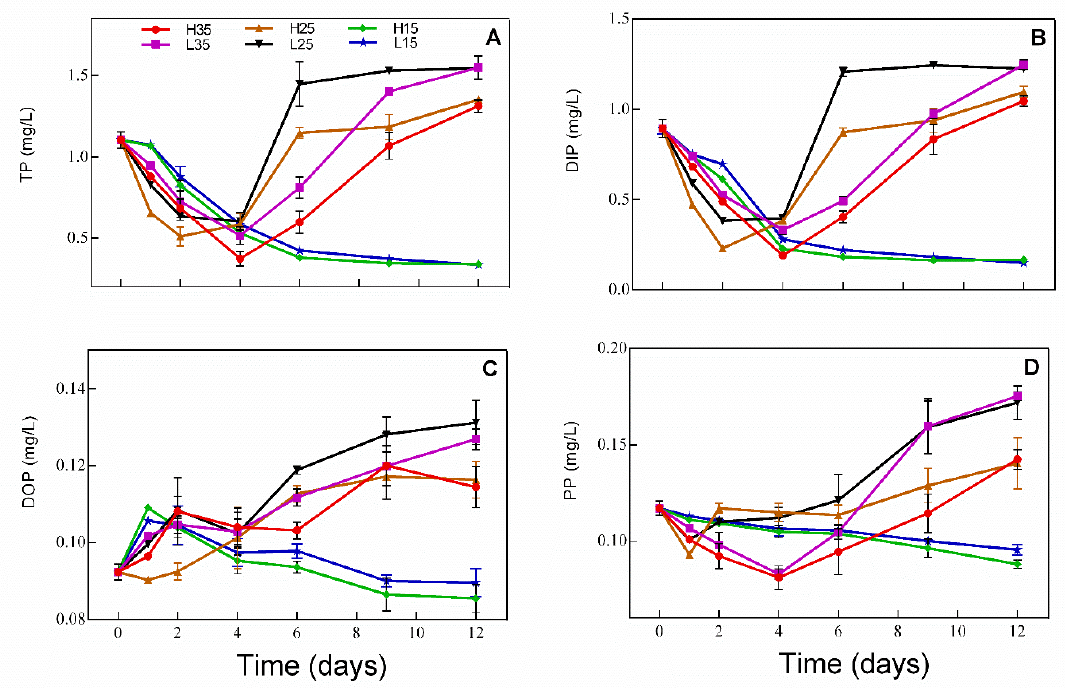
Figure 2. Concentration changes in the different forms of phosphorus (( A ) TP, ( B ) DIP, ( C ) DOP, and ( D ) PP) in water in different treatments during the experiment.